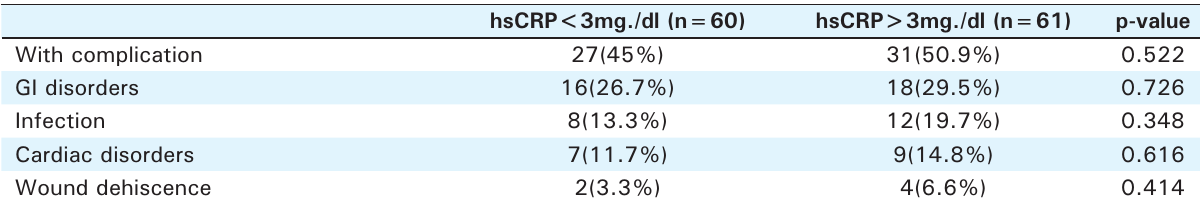
Table 4. Comparison of post operative morbidity on D-7among study subjects grouped according to hsCRP level < or> 3mg/dl